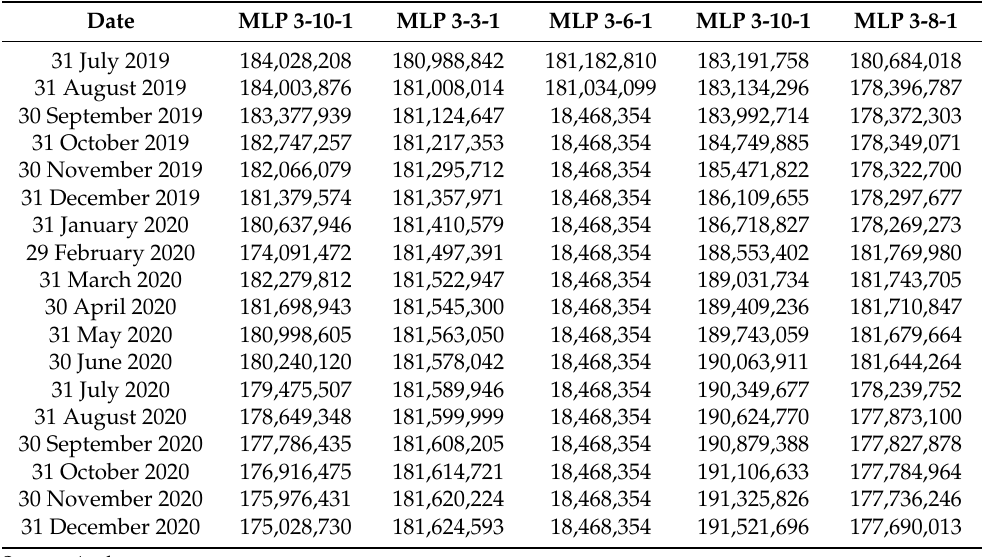
Table 3. Predicted exports from July 2019 to December 2020 according to the retained ANN (artificial neural networks) (Experiment 1).